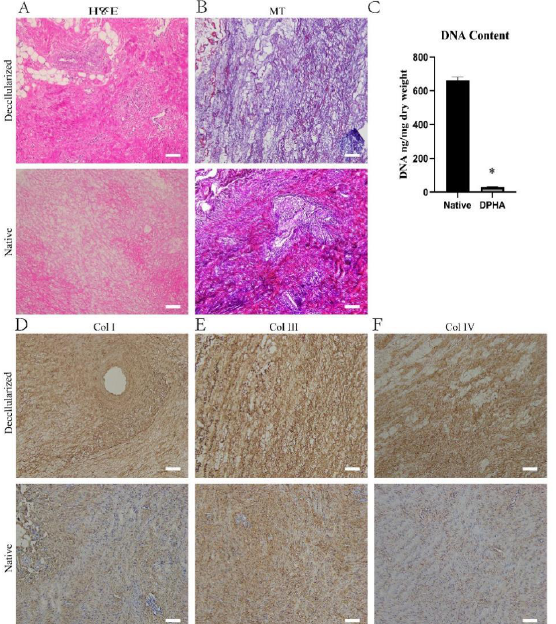
Figure 1. Characteristics of the decellularized porcine heart aortic scaffolds. ( A ) Hematoxylin and eosin staining and ( B ) Masson’s trichrome (MT) staining of native and decellularized porcine heart aortic scaffolds. ( C ) Relative DNA content in native and decellularized porcine heart aortic scaffolds. ( D ) Collagen I, ( E ) collagen Ⅲ , and ( F ) collagen IV staining of native and decellularized porcine heart aortic scaffolds. * p < 0.05 versus the native group. Scale bar = 100 μm.